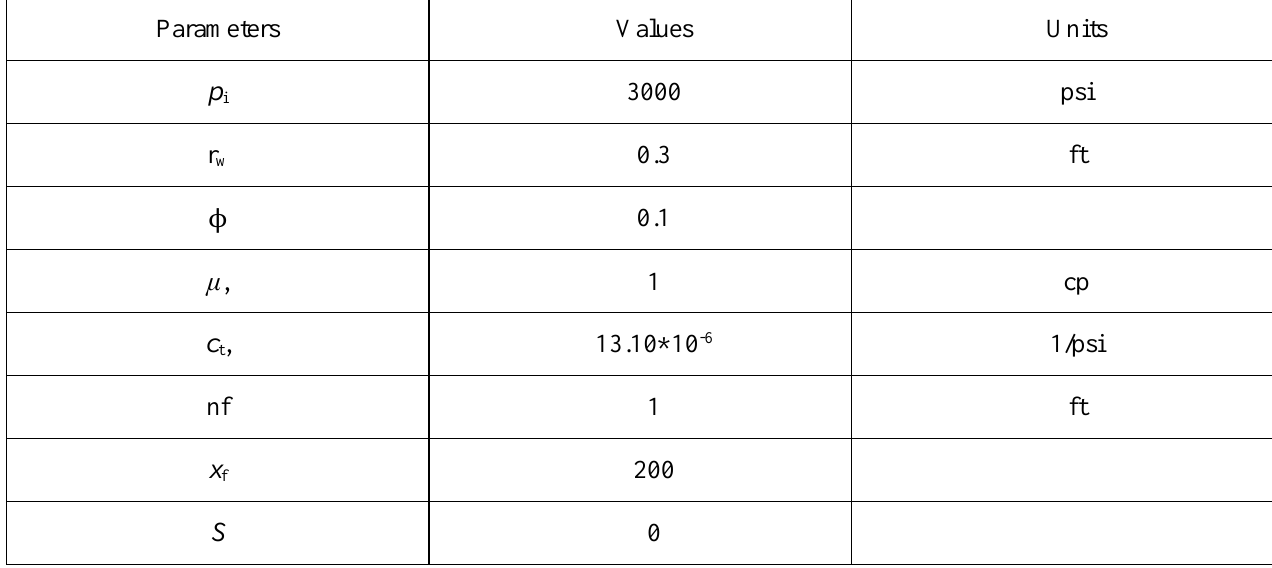
Table 1—Reservoir properties for model analysis.